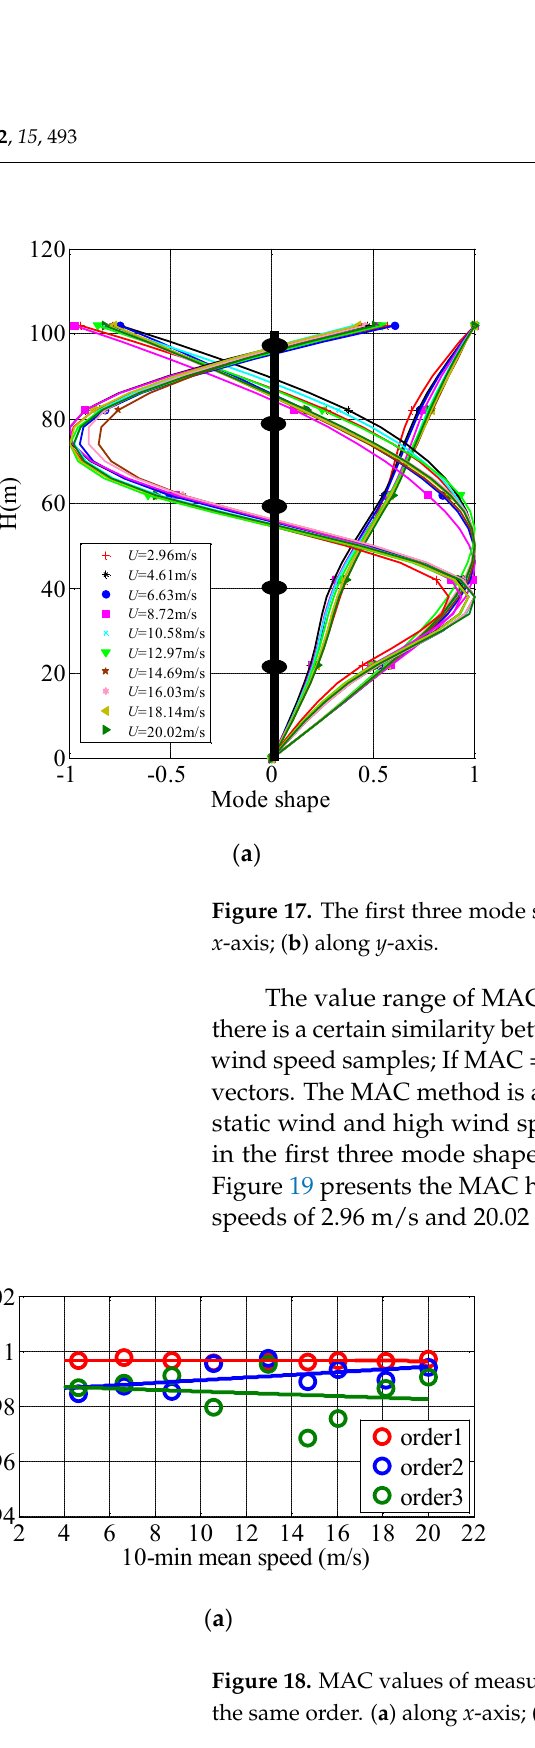
Figure 18. MAC values of measured U 10min relative to 2.96 m/s in the first three mode shapes with the same order. ( a ) along x -axis; ( b ) along y -axis.